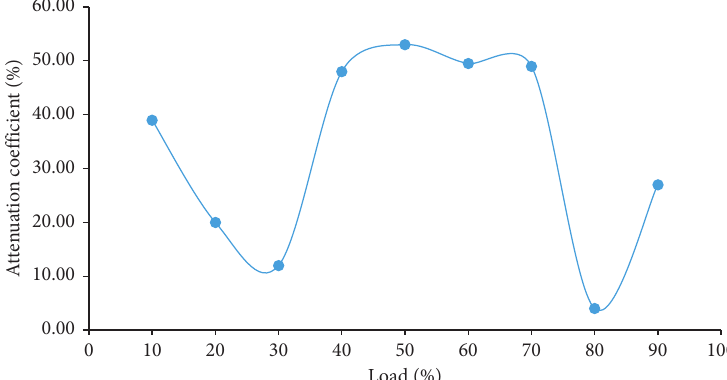
Figure 12: Attenuation coefficient versus time curve for different load percentage.